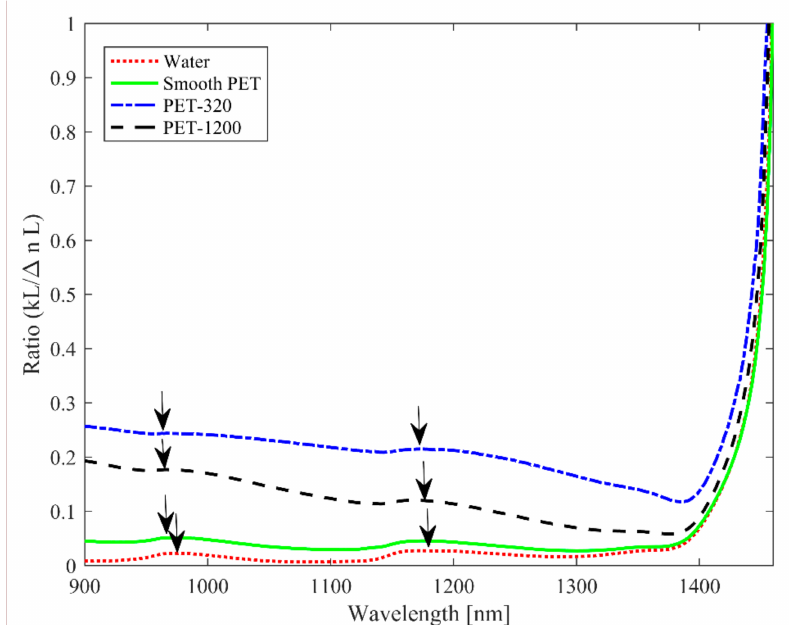
Figure 5. Ratio ( σ ) curves for water, smooth, and rough PET macroplastics with di ff erent average surface roughness water. The average surface roughness of the PET-320 and PET-1200 samples is Ra = 1.10 µ m and Ra = 0.34 µ m, respectively. The short arrows indicate the positions of the